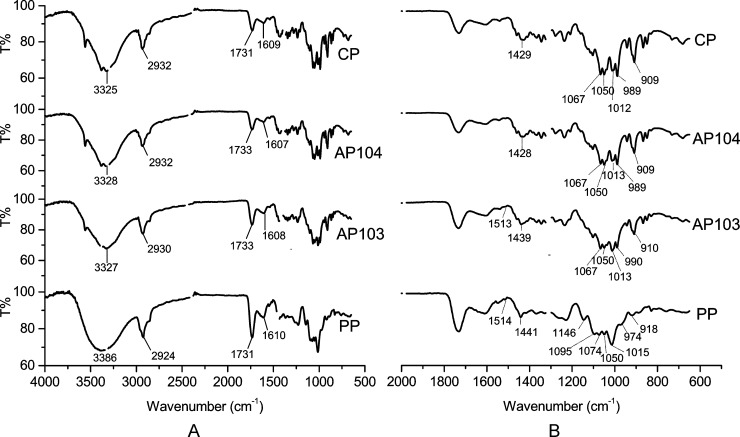
The FTIR-ATR spectra of the pumpkin, citrus and apple pectins.PP–C. maxima pectin; CP–citrus pectin; APA103 and APA104 –apple pectins. A–FTIR-ATR spectra in the 500–4000 cm-1 range; B–fingerprint region of pectins.